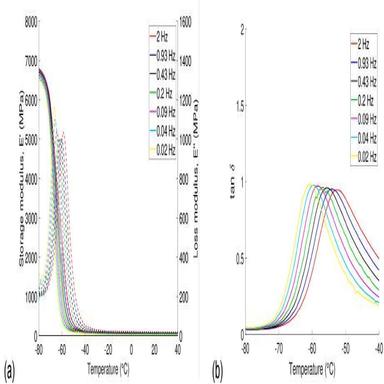
DMA results for F-NR5: (a) temperature dependent storage (solid line) and loss (dashed line) moduli and (b) loss tangents.